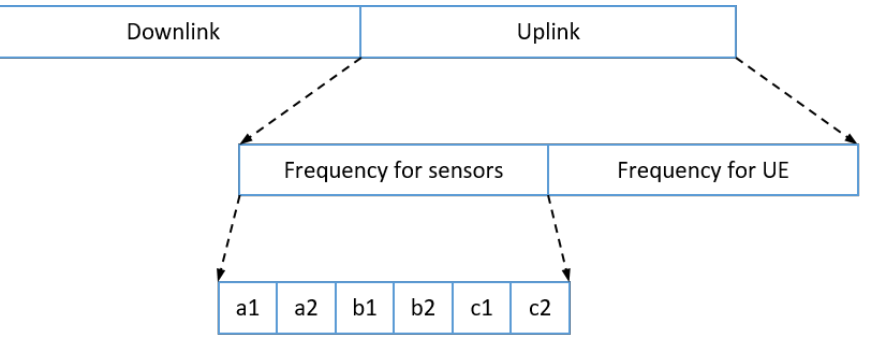
Figure 4. Frequency partitioning in